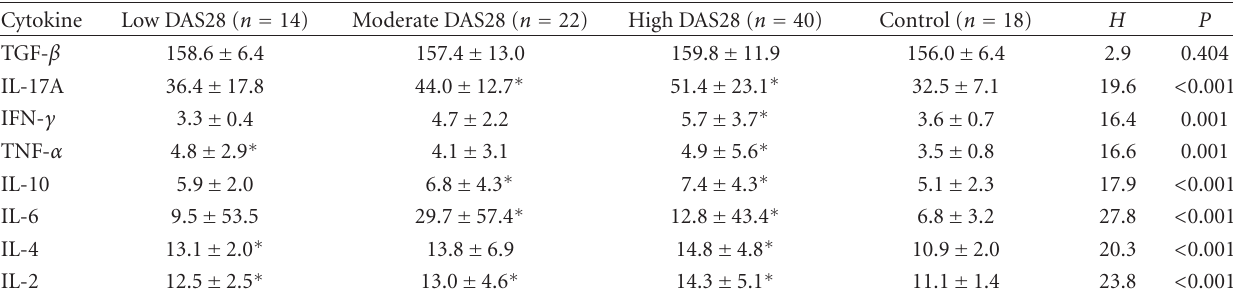
Table 3: Th cell-related cytokine changes of RA patients with di ff erent DAS28 scores.